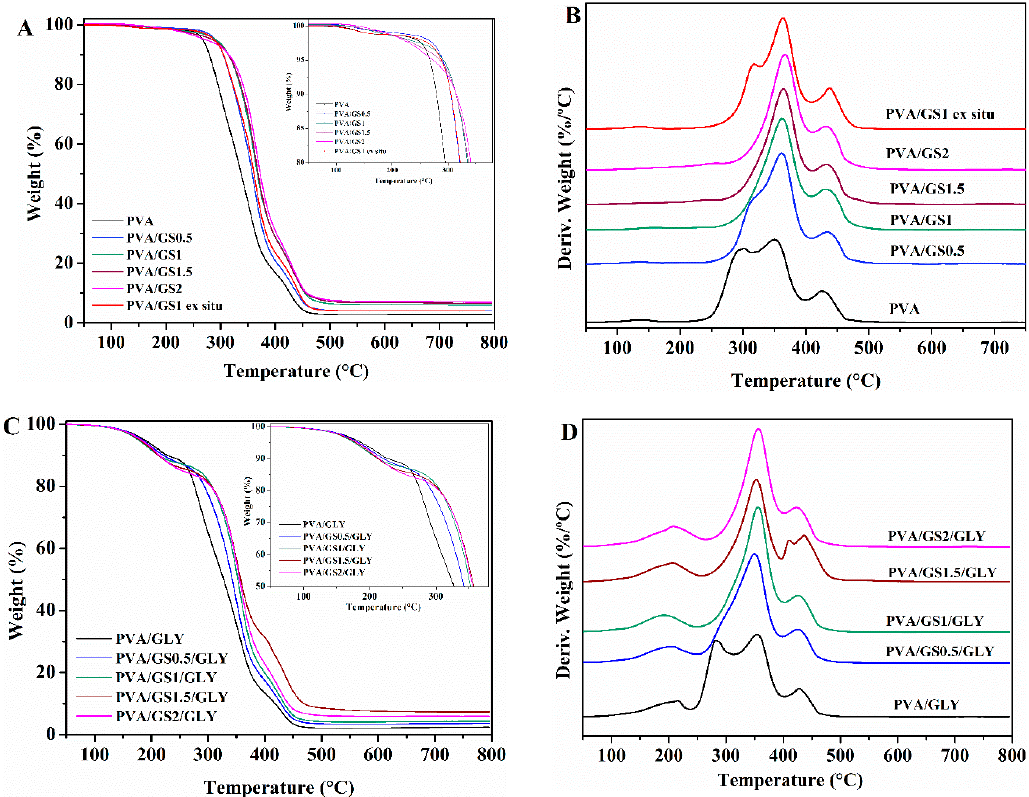
Figure 8. TG and DTG curves: ( A , B ) unplasticized, and ( C , D ) glycerol plasticized PVA and PVA/GS nanocomposites in N 2 .